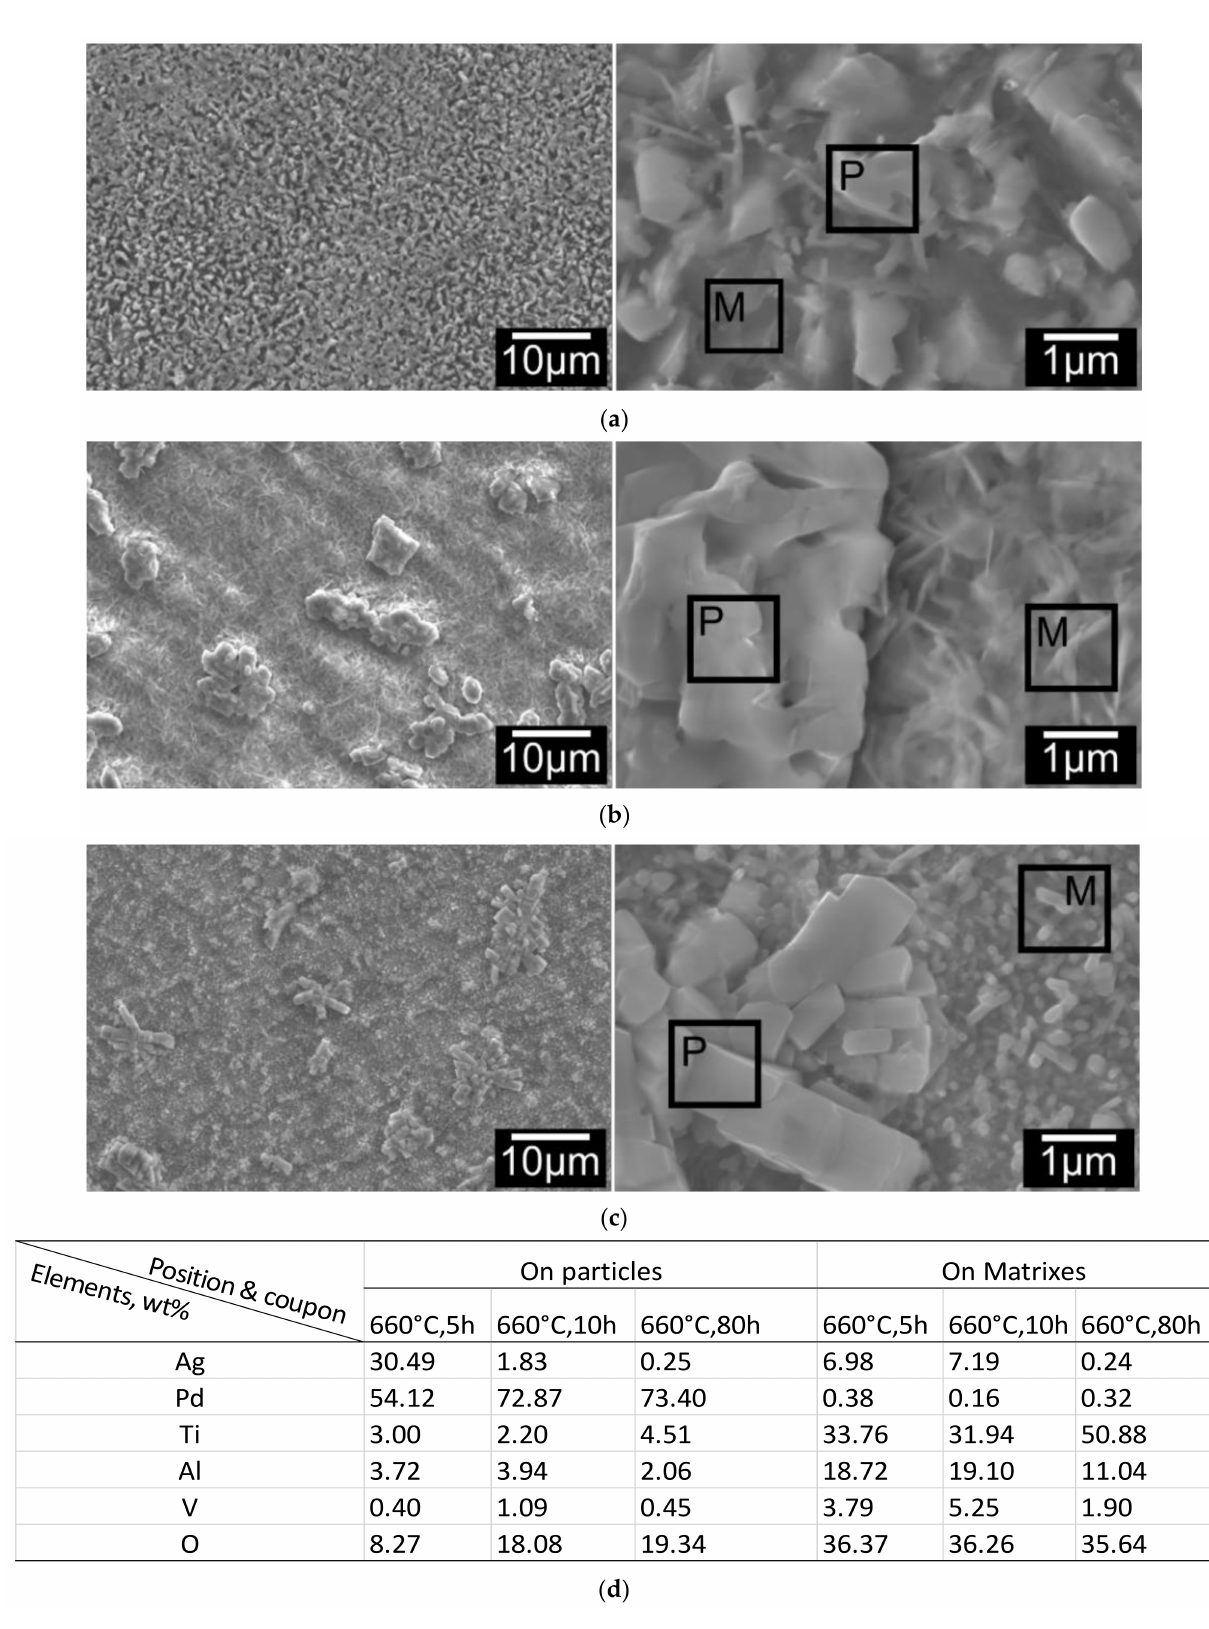
Figure 4. Surface morphology change of C3TAgPd coupons, treated at 660 ◦ C for ( a ) 5 h; ( b ) 10 h and ( c ) 80 h. ‘P’ and ‘M’ denote particle and matrix, respectively; ( d ) elemental analysis on the spots of agglomerated particles and matrix grains for 5, 10 and 80 h treated coupons (see denoted P and M in